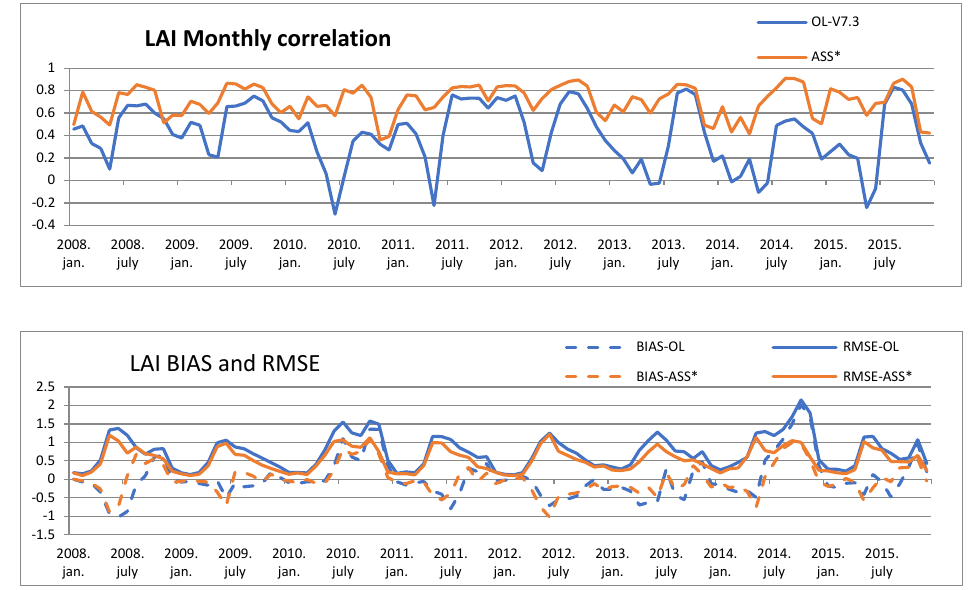
Figure 10. Seasonal correlation (top); BIAS (bottom, dashed line) and RMSE (bottom full line)) for LAI for open-loop (blue) and assimilation (orange) runs.